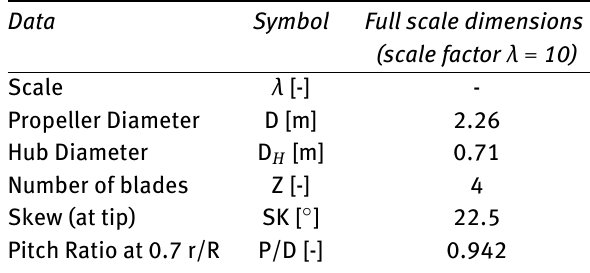
Table 2: Main dimensions in full scale of the RV Nawigator XXI con- trollable pitch